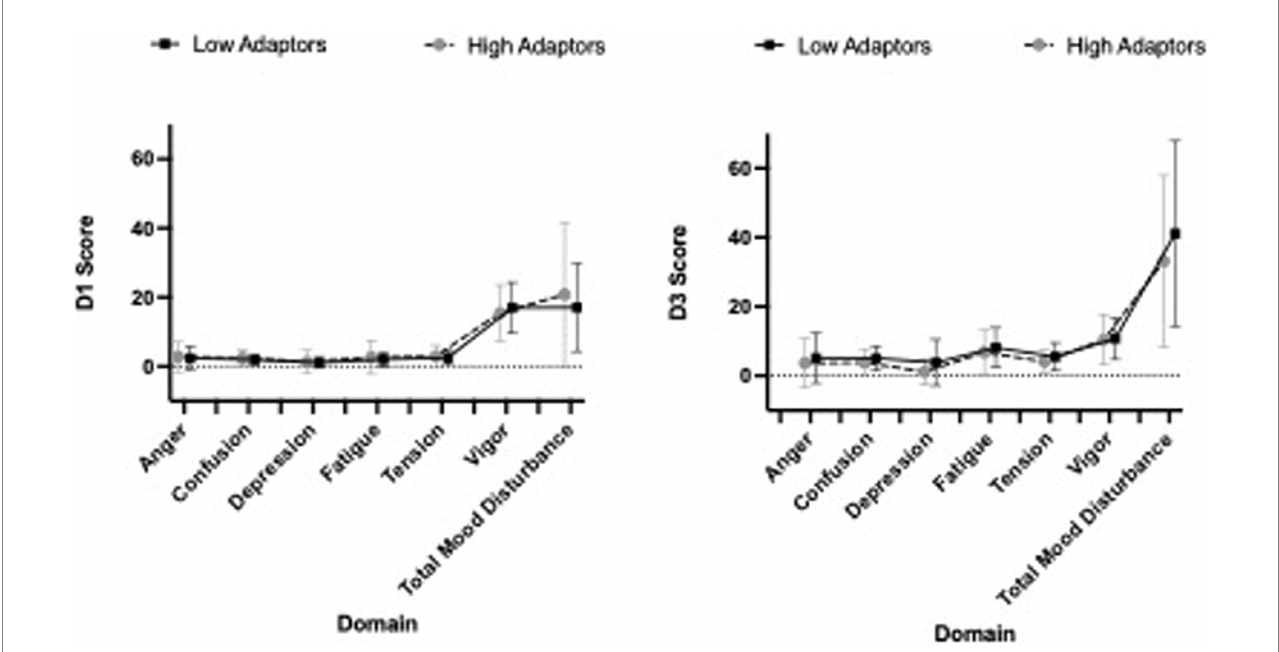
FIGURE 2 Profile of Mood States (POMS) scores stratified by low and high adaptive groups are presented in Figure 2. Baseline scores (D1) are presented on the left, while D3 (peak stress) scores are presented on the right.